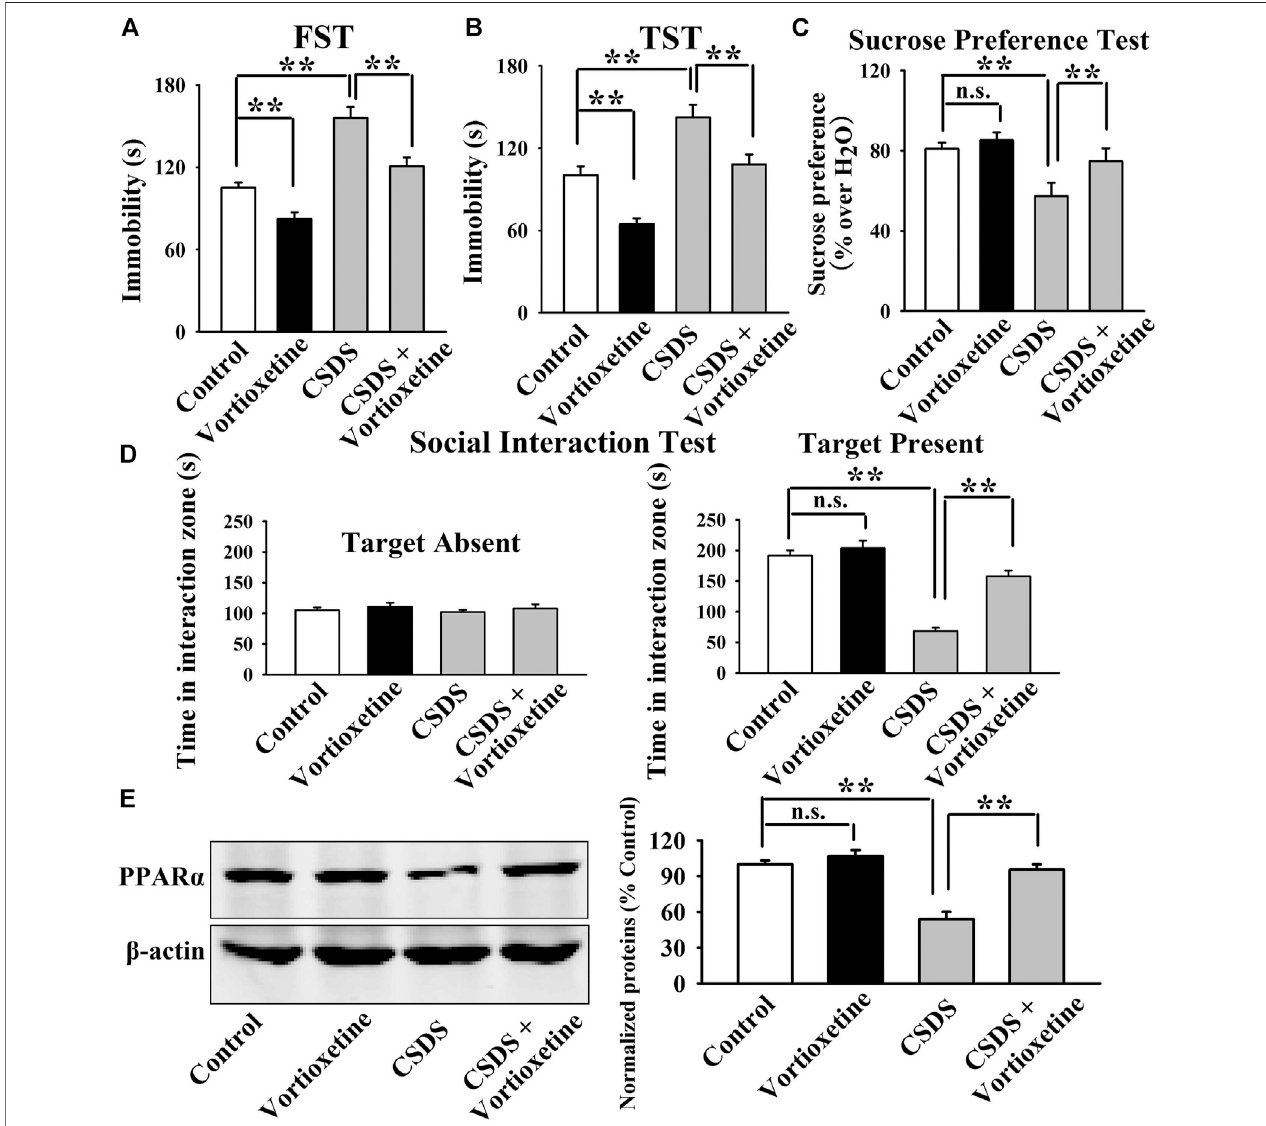
FIGURE 2 | The CSDS-induced decrease in the hippocampal PPAR α expression was fully restored by repeated vortioxetine treatment. (A – D) The antidepressant effects of vortioxetine in the CSDS model, as detected by the FST, TST, sucrose preference test and social interaction test. C57BL/6J mice subjected to 10 days of CSDS were daily injected with vehicle/vortioxetine for another 2 weeks, and then subjected to behavioral tests. (E) Representative images and quantitative analyses showthatvortioxetineadministrationnotablypreventedtheinhibitoryeffectsofCSDSonthehippocampalPPAR α expression.For (A – D) , n (cid:2) 10pergroup;For (E) , n (cid:2) 5 per group. The data are expressed as the means ± S.E.M.; ** p < 0.01; n.s., no signi fi cance. The comparisons were made by two-way ANOVA followed by Bonferroni ’ s test.